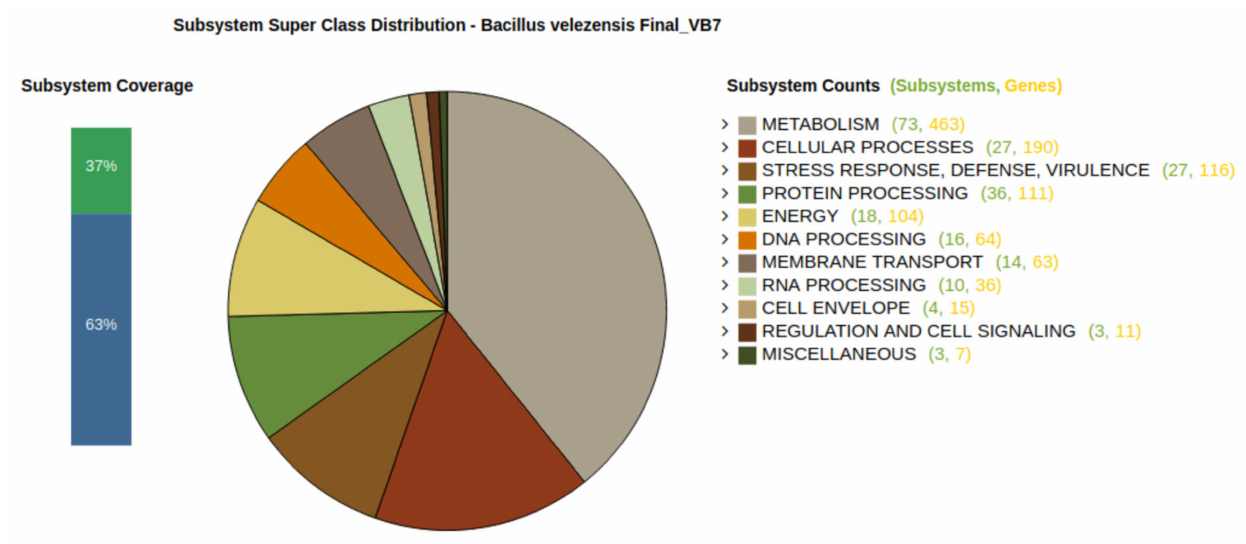
Figure 2. Subsystem Analysis of the Genome Bacillus velezensis